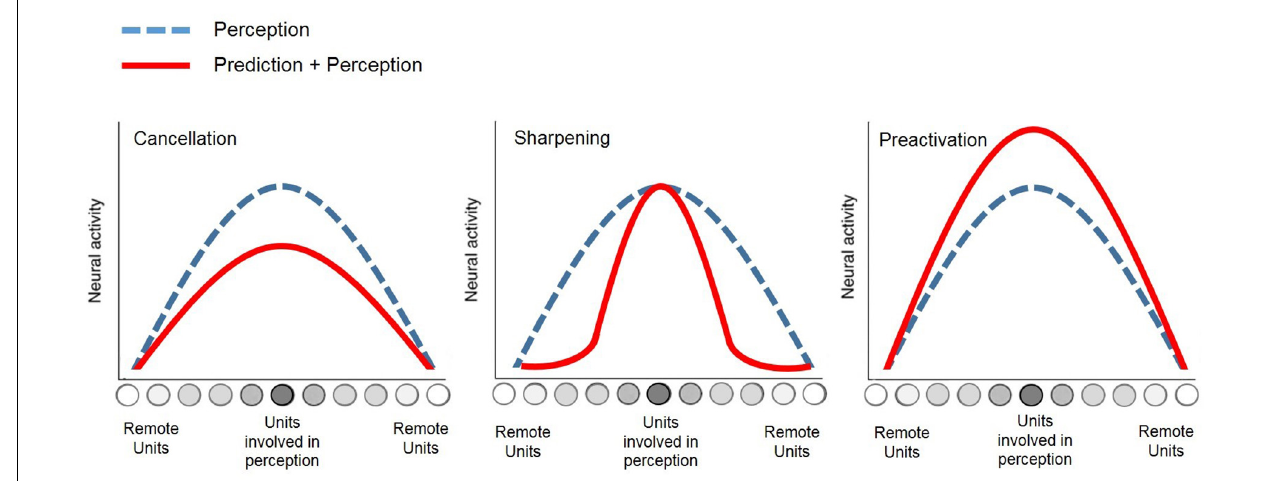
FIGURE 1 | Schematic of neural patterns underlying action-effect prediction relative to